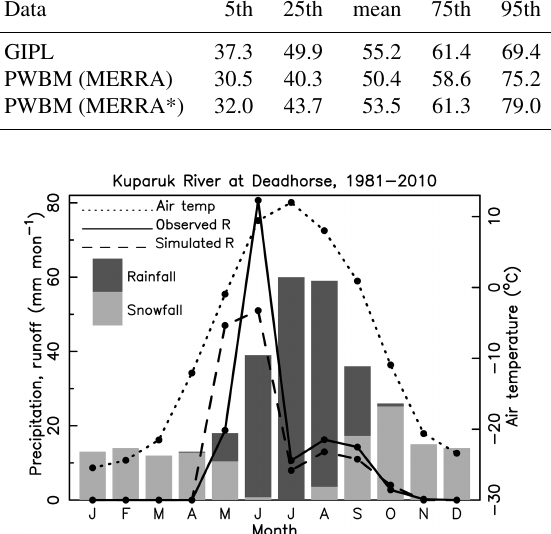
Figure 2. Simulated and observed runoff ( R , mmmonth − 1 ) for the Kuparuk River basin 1981–2010. Simulated R expressed in unit depth was calculated from the routed river discharge ( Q ) volume. Observed R was drawn from the USGS Water Data for the Nation database (USGS Kuparuk River, 2019) (Sect. 2.1). The PWBM sim- ulation was forced with meteorological data from the MERRA re- analysis, with precipitation adjustment (MERRA*) as described in Sect. 2.2. Monthly air temperature is the average over the Kuparuk basin from the MERRA data used in the model simulation. Monthly climatological precipitation ( P ) shown in totals (mmmonth − 1 ) for rainfall and